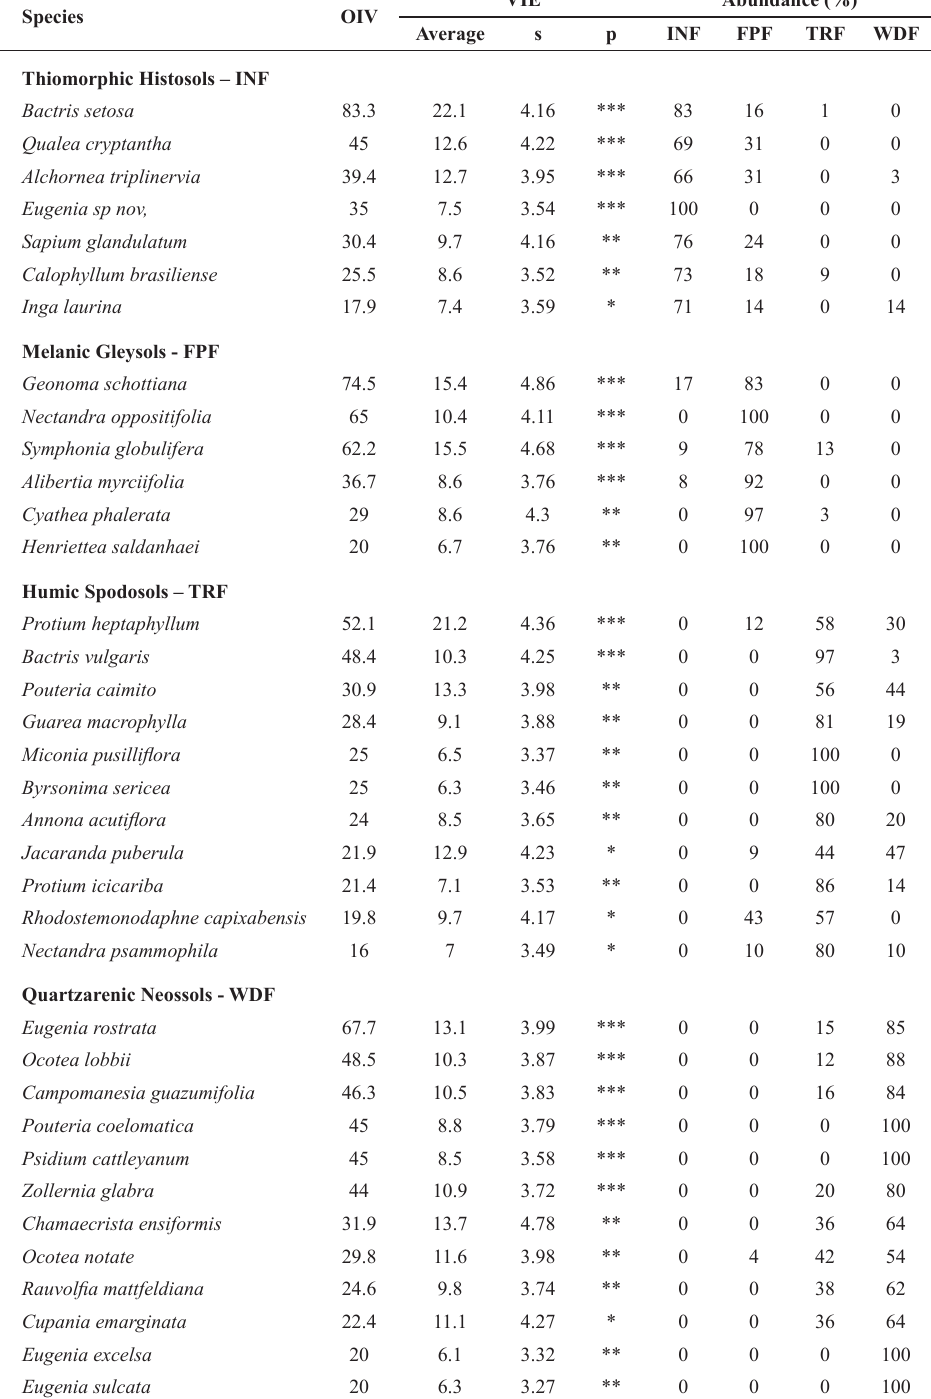
Results of the indicator species analysis in four forests studied based on soil variables and cover value of 64 species in Jacarenema Natural Municipal Park, Vila Velha, Brazil. OIV=Observed indicator value; VIE=expected value indicator; s=standard deviation, p=significance level; INF=Inundated Forest; FPF=Floodplain Forest; TRF=Transitional Forest; WDF=Well-drained